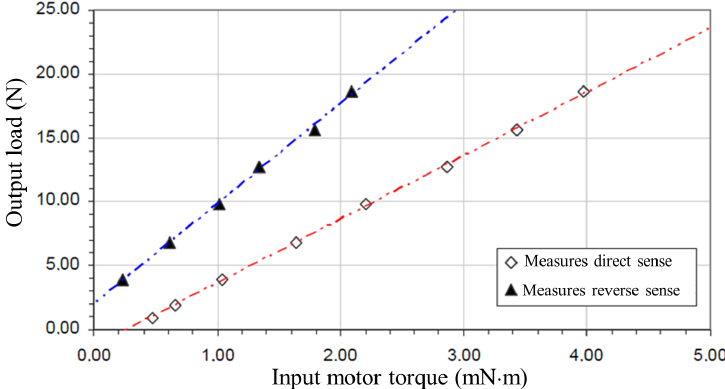
Figure 2. Experimental measures on the ball-screw